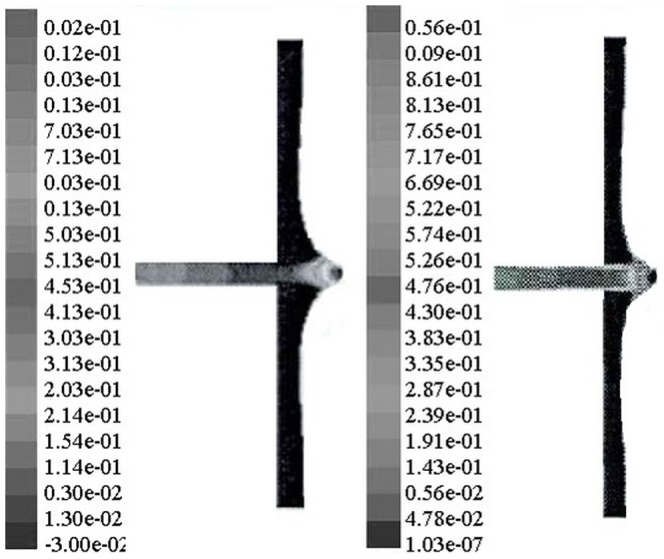
Contour of static and dynamic pressure distribution in YZ plane.(a) Static. (b) Dynamic.